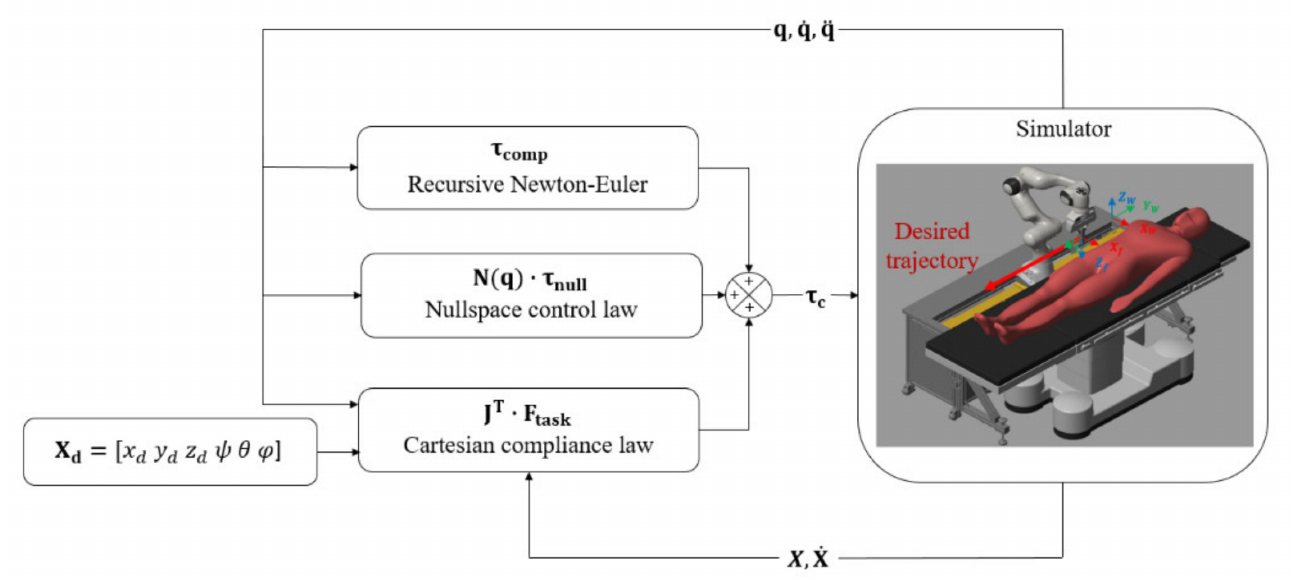
Figure 8. Control schema implemented in the dynamic